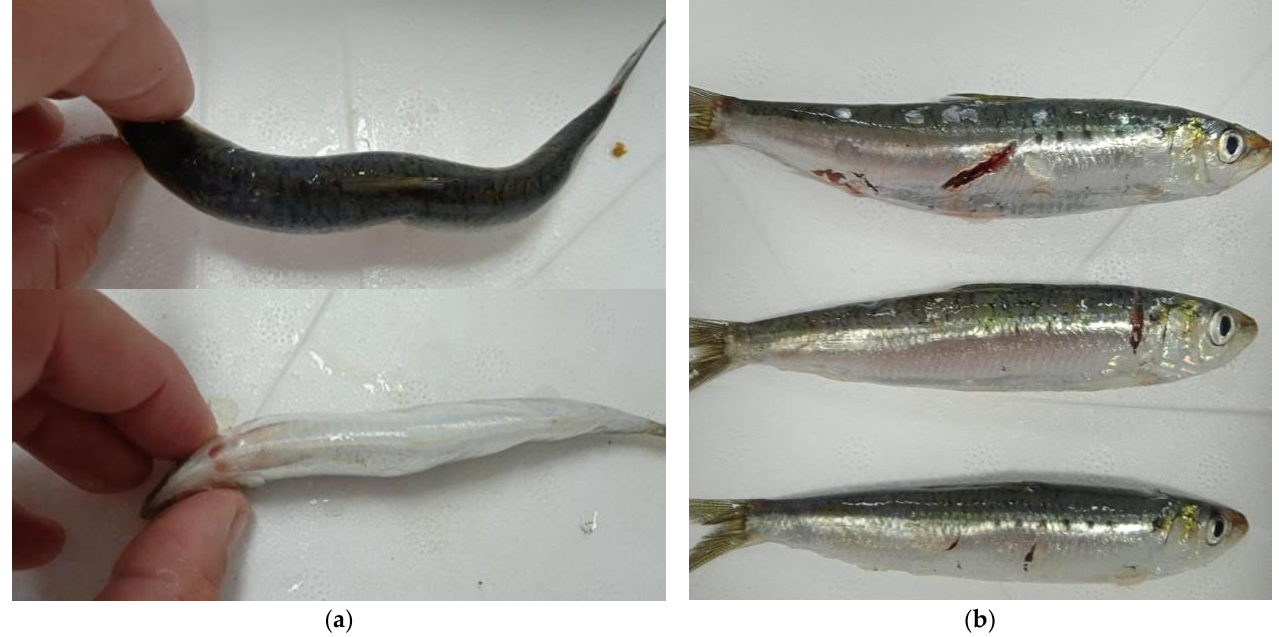
Figure 1. Observed physical damage in samples: ( a ) indentations and irregular shape on samples A and B loaded by brail net and ( b ) damaged skin on sample C loaded by